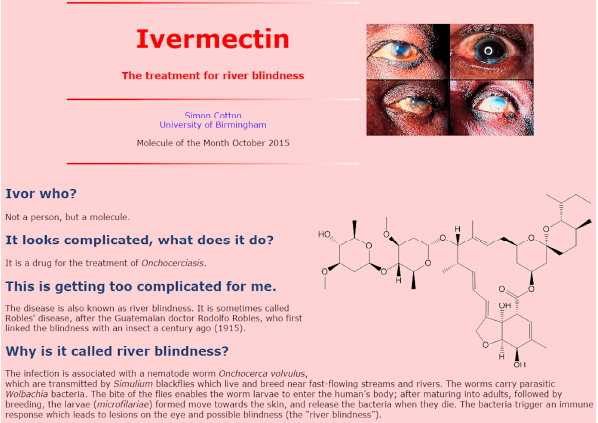
Figure 3. The Q&A style used in most MOTM pages, including this one about ivermectin